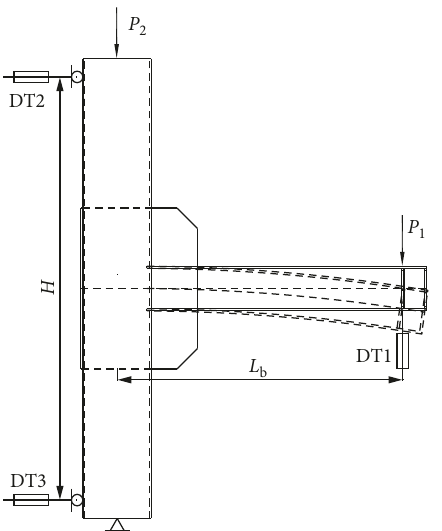
Figure 5: Layout of the displacement